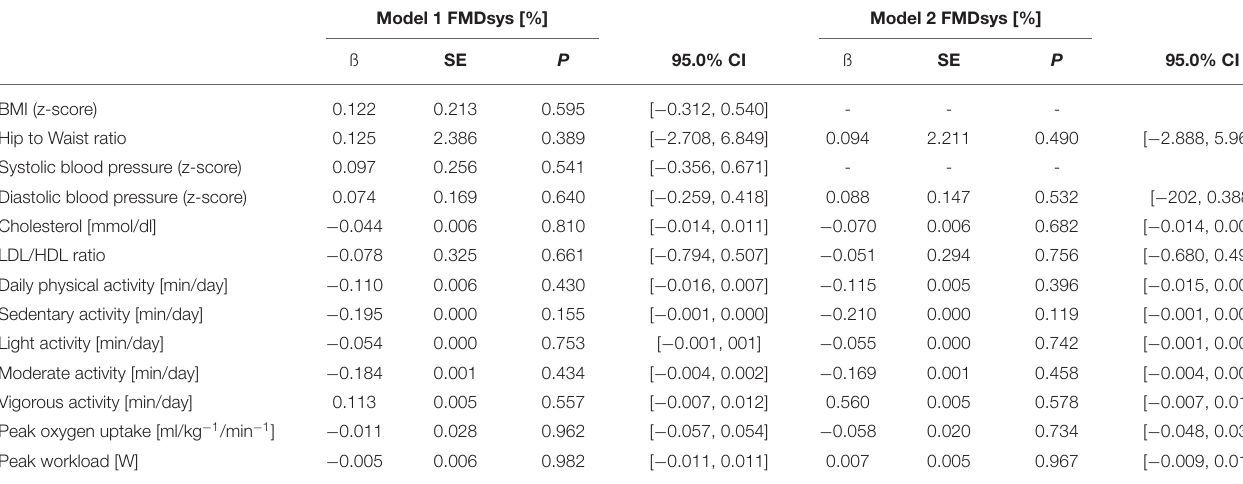
TABLE 4 | Multivariable correlates of endothelial function measured by flow-mediated